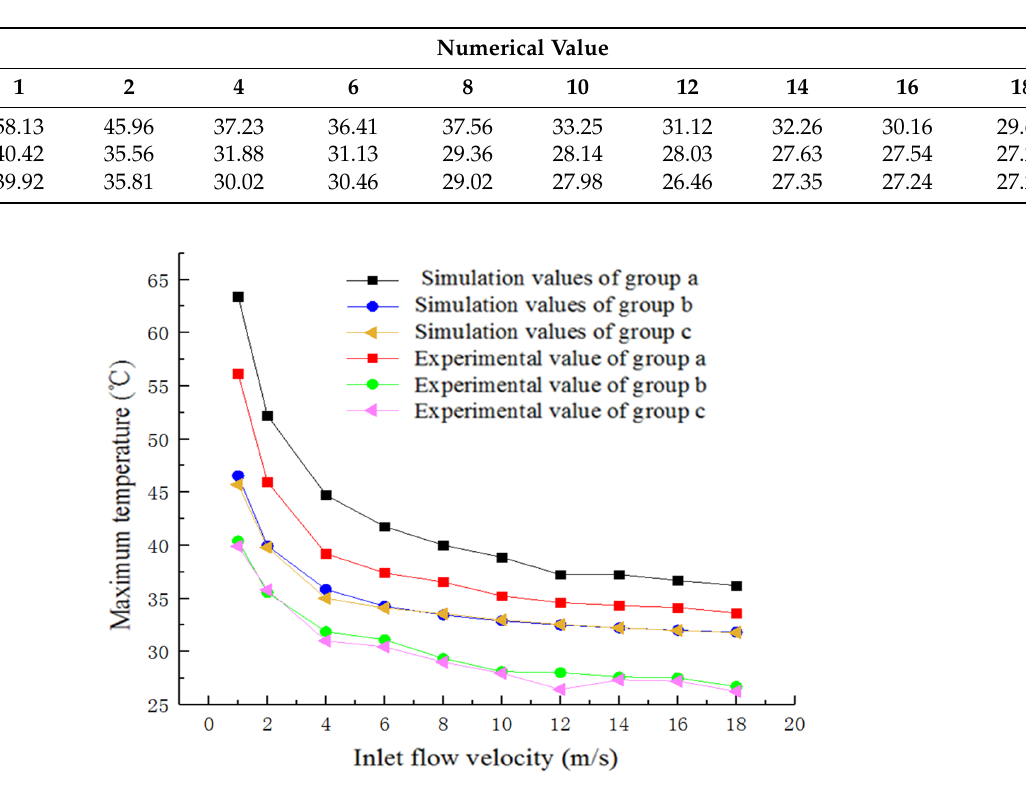
Figure 10. Comparing the relationship between experimental and simulated values of maximum static temperature and inlet flow velocity for different spoiler column structures.